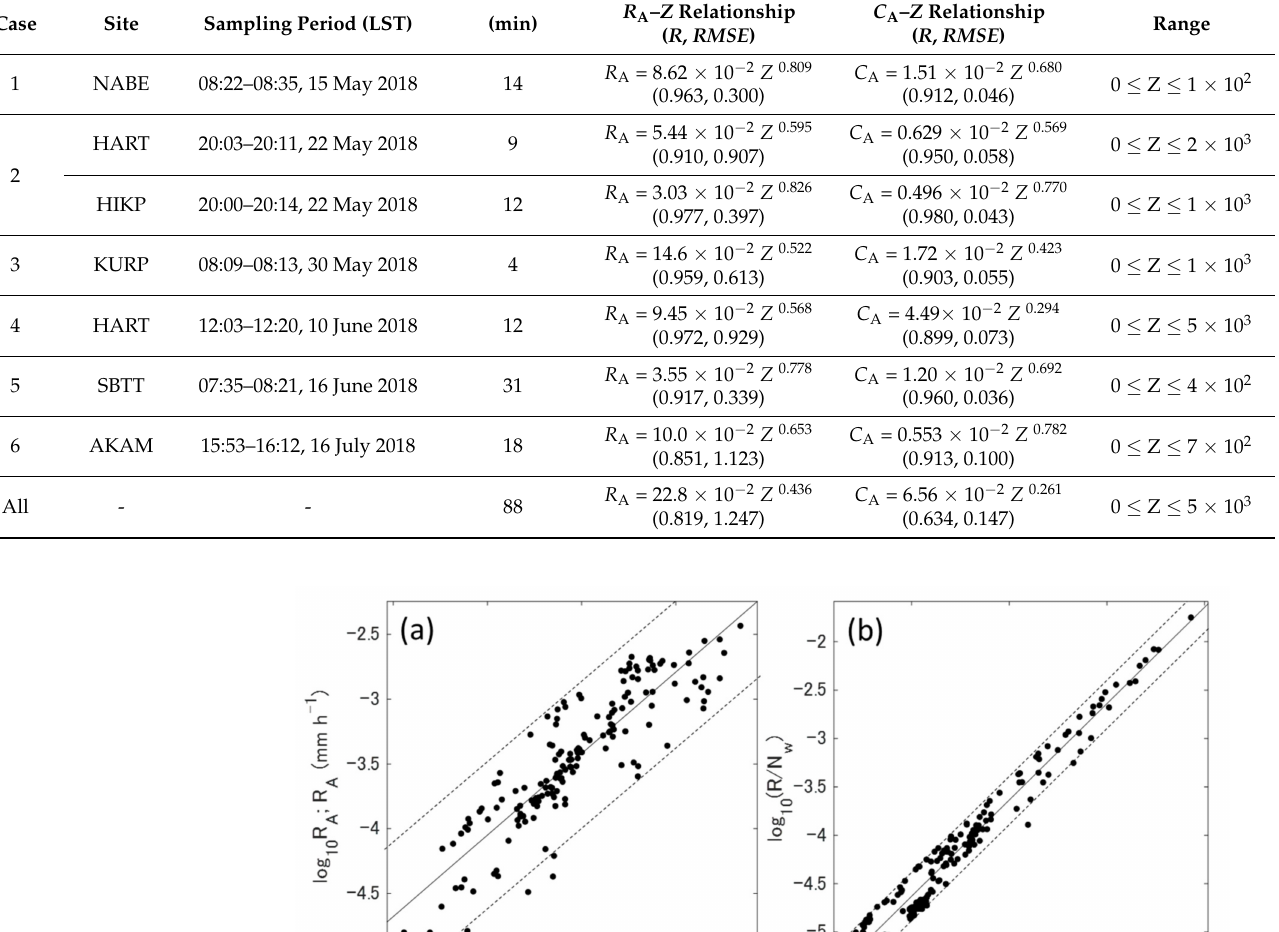
Table 6. R A – Z and C A – Z relationships obtained from regression analyses of PSD data measured by Parsivel 2 . Note that R A (mm h − 1 ), C A (g m − 3 ), Z (mm 6 m − 3 ). R : correlation coefficient, RMSE : root mean square error. ρ b = 1.25 × 10 3 kg m − 3 and ρ p = 2.50 × 10 3 kg m − 3 were assumed for the estimation of R A .